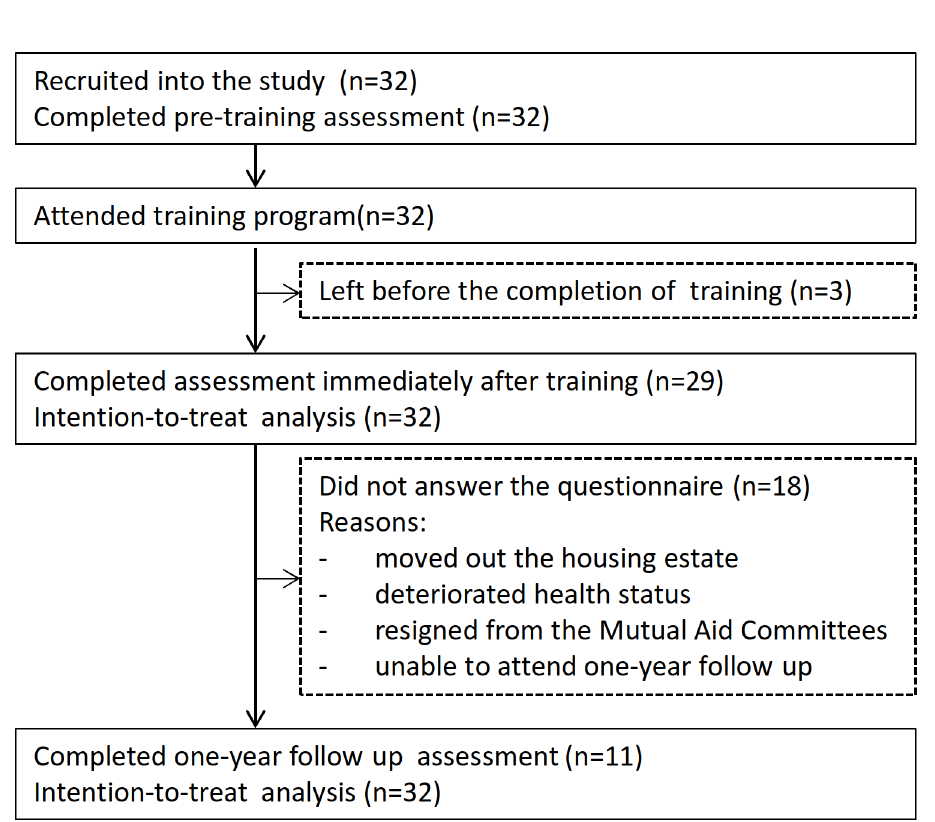
Fig 2. The lay health promoters’ flow